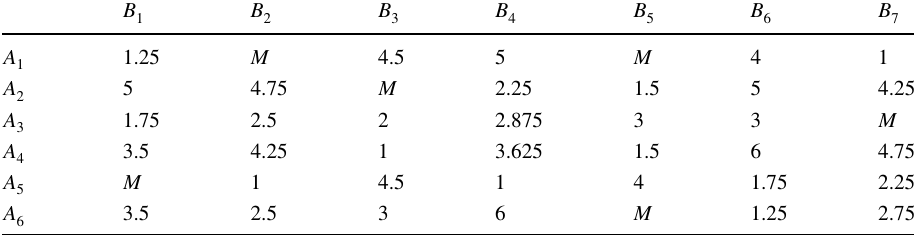
Table 4 Expectation ordinal